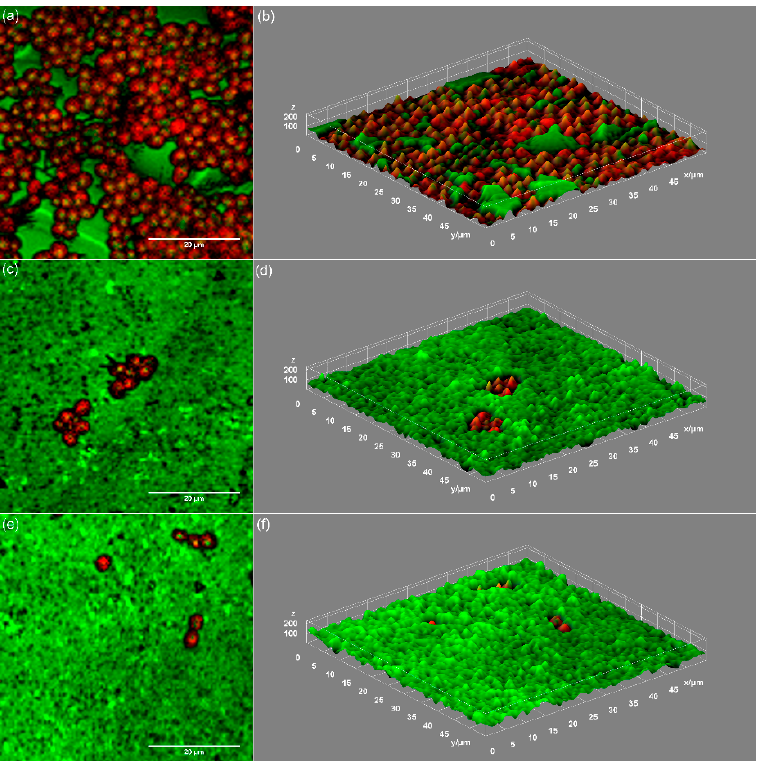
Figure 14. 2D CLSM images and 3D representation of CLSM images of Candida albicans ATCC 10231 cell development on HAp ( a , b ), 0.05 AgHAp ( c , d ), and 0.1 AgHAp ( e , f ) coatings after 48 h of incubation.